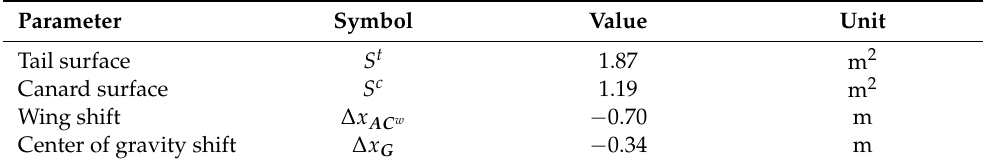
Table 4. Basic features of three-surface configuration. Longitudinal distances positive forward.